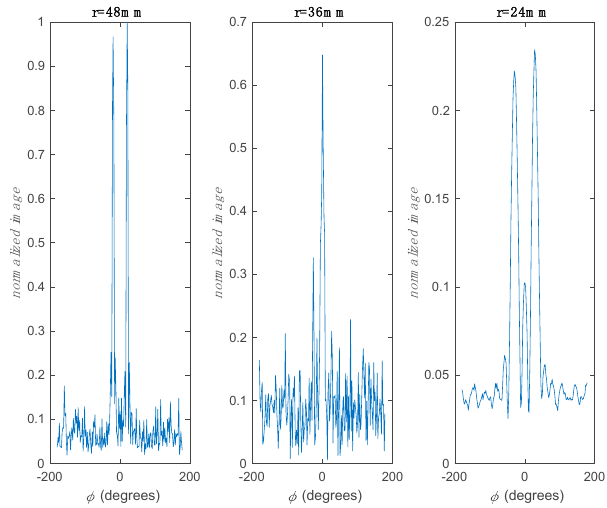
Figure 5. Normalized 2D reconstructed image of objects with a side of D = 5 mm on three imaged circles with radii of 48, 36 and 24 mm using double frequency data collected by eight receiver antennas.